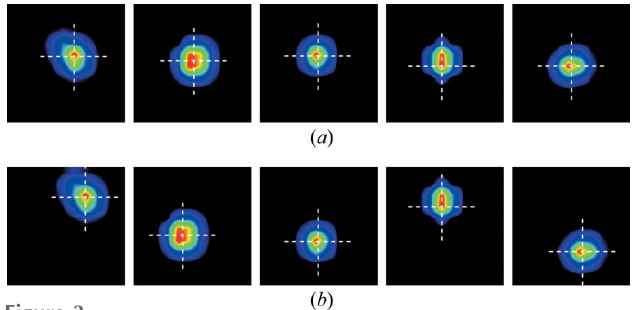
Figure 3 Demonstration of a mini-batch of patches (11 (cid:3) 11 pixels) with data augmentation for model training. ( a ) The peak maxima is in the center of the patch. ( b ) The peak maxima is intentionally offset by up to (cid:4) 2 pixels in the horizontal and vertical directions for the same